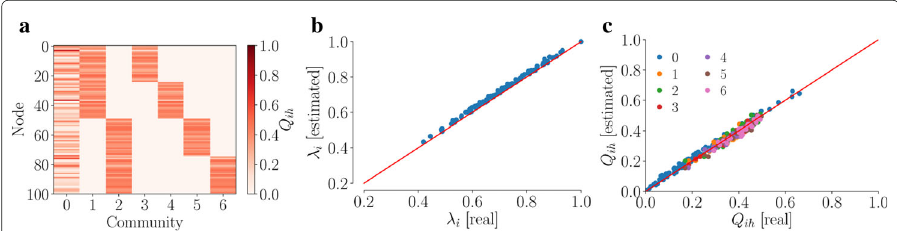
Fig. 9 Validation on a synthetic network with hierarchical communities. In ( a ), matrix Q is illustrated (color intensity is proportional to the value of the entry). Estimations of the vector λ and of the matrix Q are